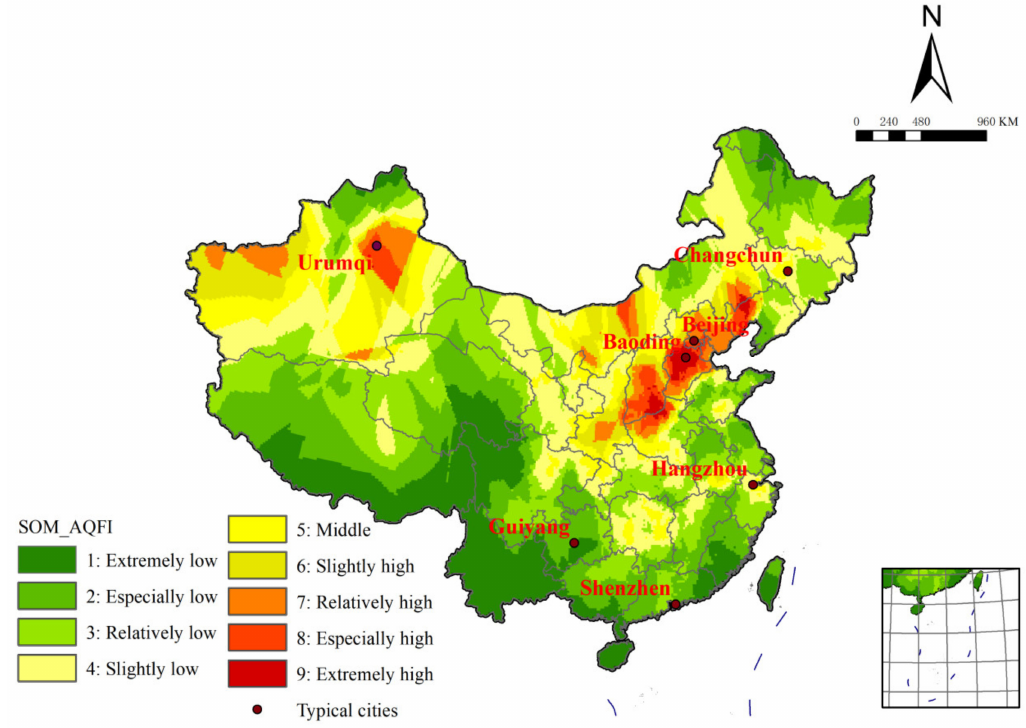
Figure 4. The spatial distribution of typical